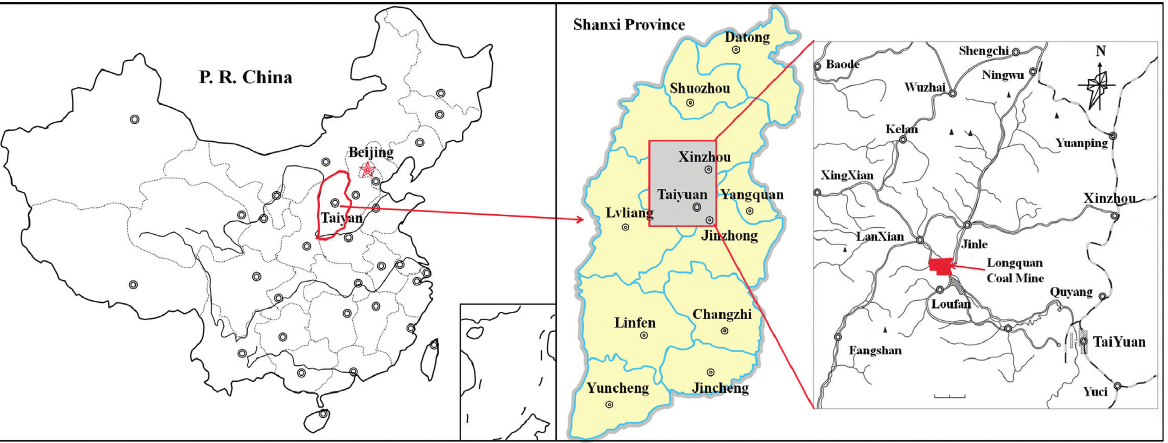
Figure 4: Location of the Longquan coal